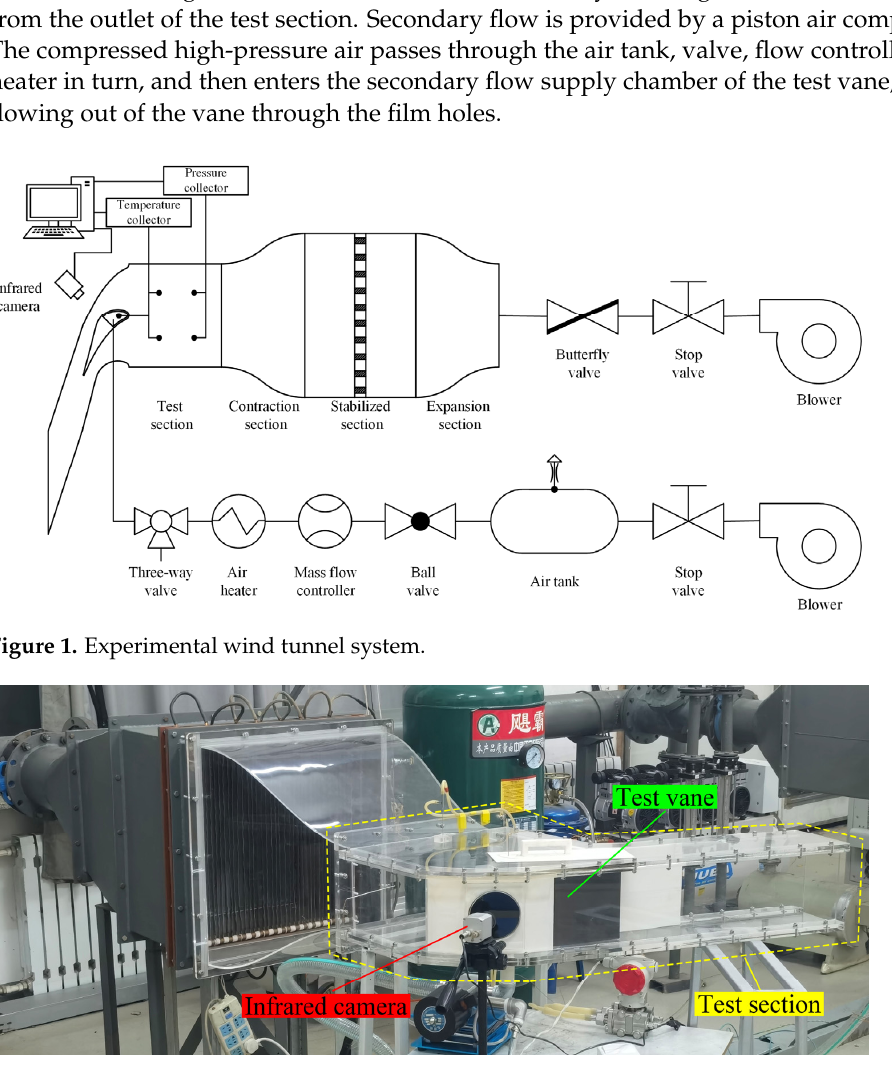
Figure 2. Photo of wind tunnel setup.